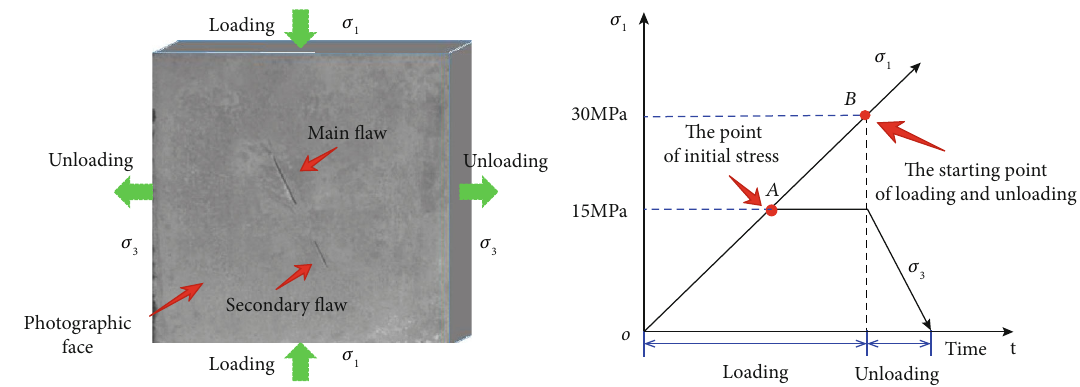
Figure 8: Schematic diagram of test stress setting and stress path.